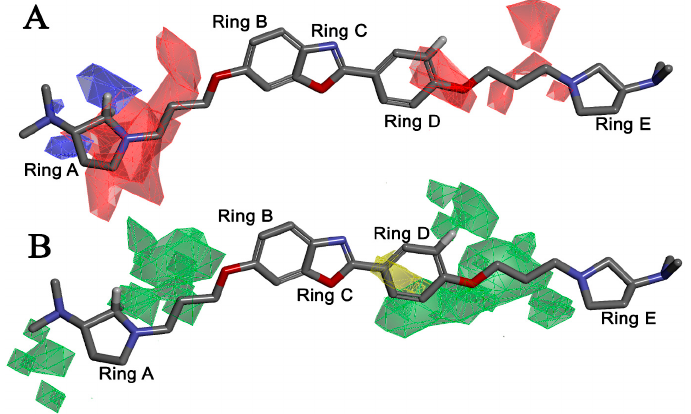
Figure 11. Pictorial representation of the 3D-QSAR model coefficients on ( A ) electrostatic and ( B ) Van der Waals grids mapping quinazoline core template molecule 14 .